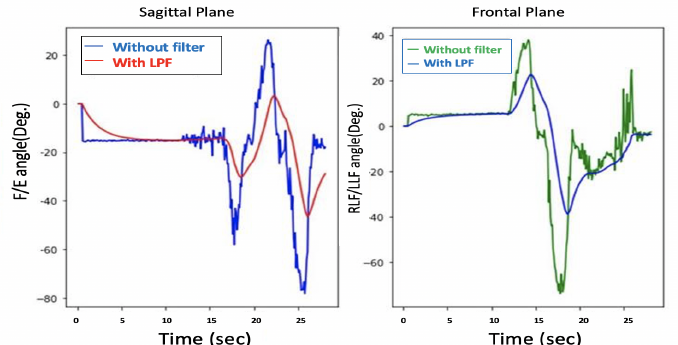
Figure 7. θ and φ before and after LPF with only Acc.